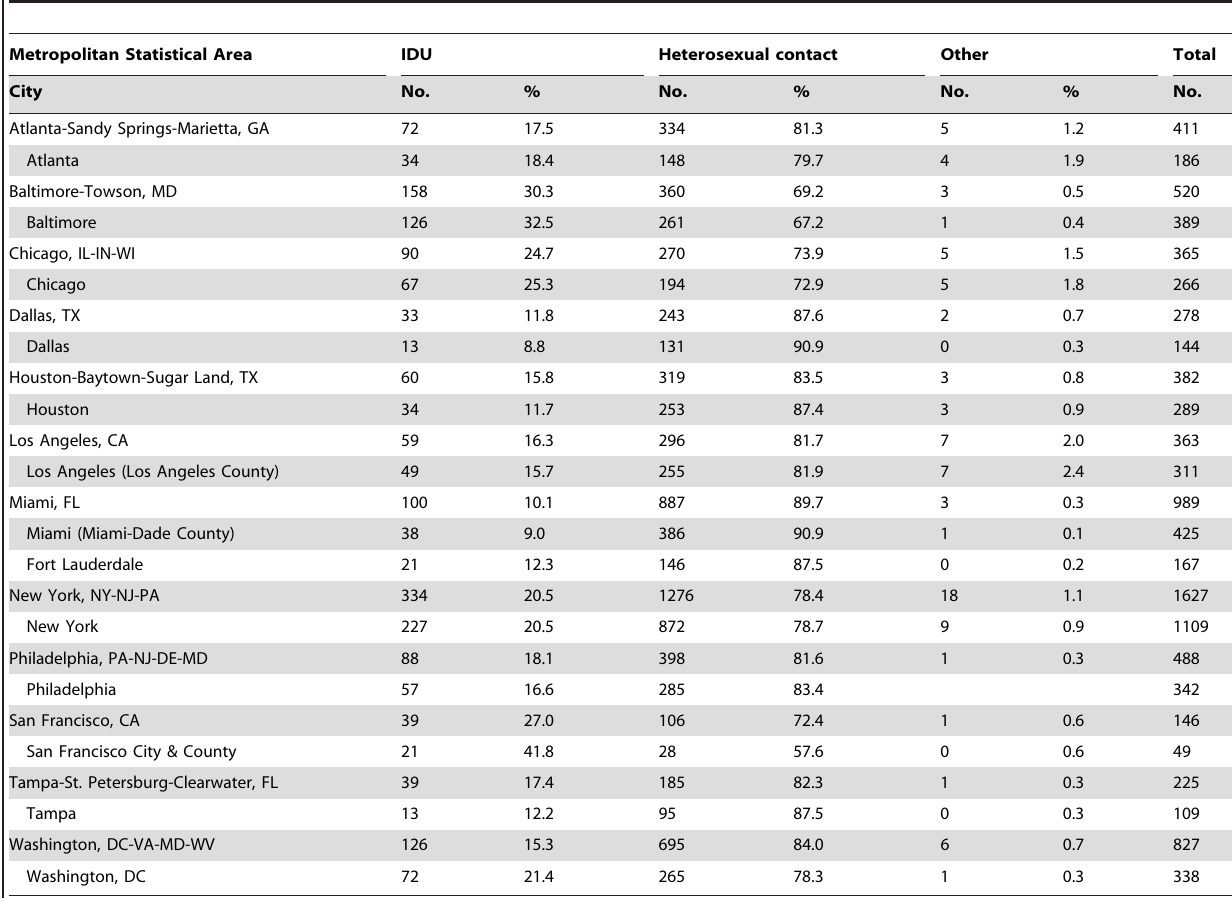
Table 3. Numbers and percentages of adult and adolescent females diagnosed with HIV infection, by transmission category and area of residence, United States,